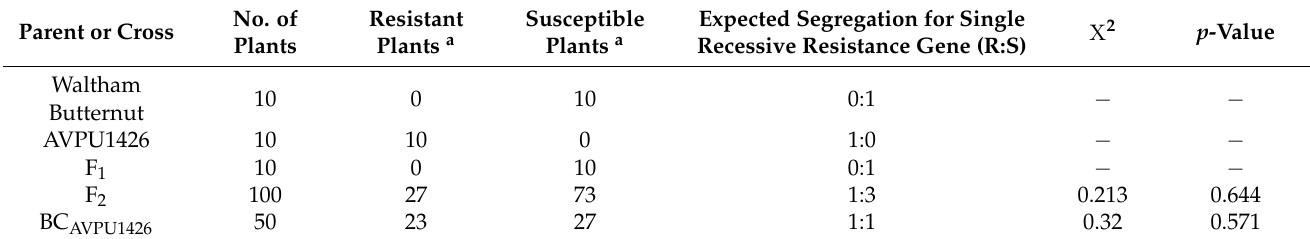
for SLCCNV and ToLCNDV resistance was performed in a greenhouse using viruliferous whiteflies. Ten plants of resistant (AVPU1426) and susceptible (Waltham Butternut) parental lines and their F 1 , and 100 and 50 plants of the F 2 and BC AVPU1426 generations (48 plants of BC AVPU1426 for SLCCNV screening), respectively, (Tables 1 and 2) were sown into the greenhouse and used in each inoculation assay. SLCCNV and ToLCNDV were maintained on pumpkin and cucumber plants in separate muslin-covered cages, respectively. Non- viruliferous whiteflies were maintained on healthy cotton ( Gossypium hirsutum ) grown in muslin-covered cages. Whiteflies were reared on cotton plants for at least 25–30 days to complete their life cycle and to obtain enough adult whiteflies for the transmission experiments. Whitefly transmission was performed by standard procedure [8]. Table 1. Segregation of SLCCNV resistance in F 1 , F 2 , and BC generations derived from the cross between AVPU1426 (resistant) and Waltham Butternut (susceptible) lines of Cucurbita moschata . Parent or Total No. Resistant Susceptible Expected Segregation for Single Х 2 p -Value Generation of Plants Plants a Plants a Recessive Resistance Gene (R:S) Waltham 10 0 Butternut